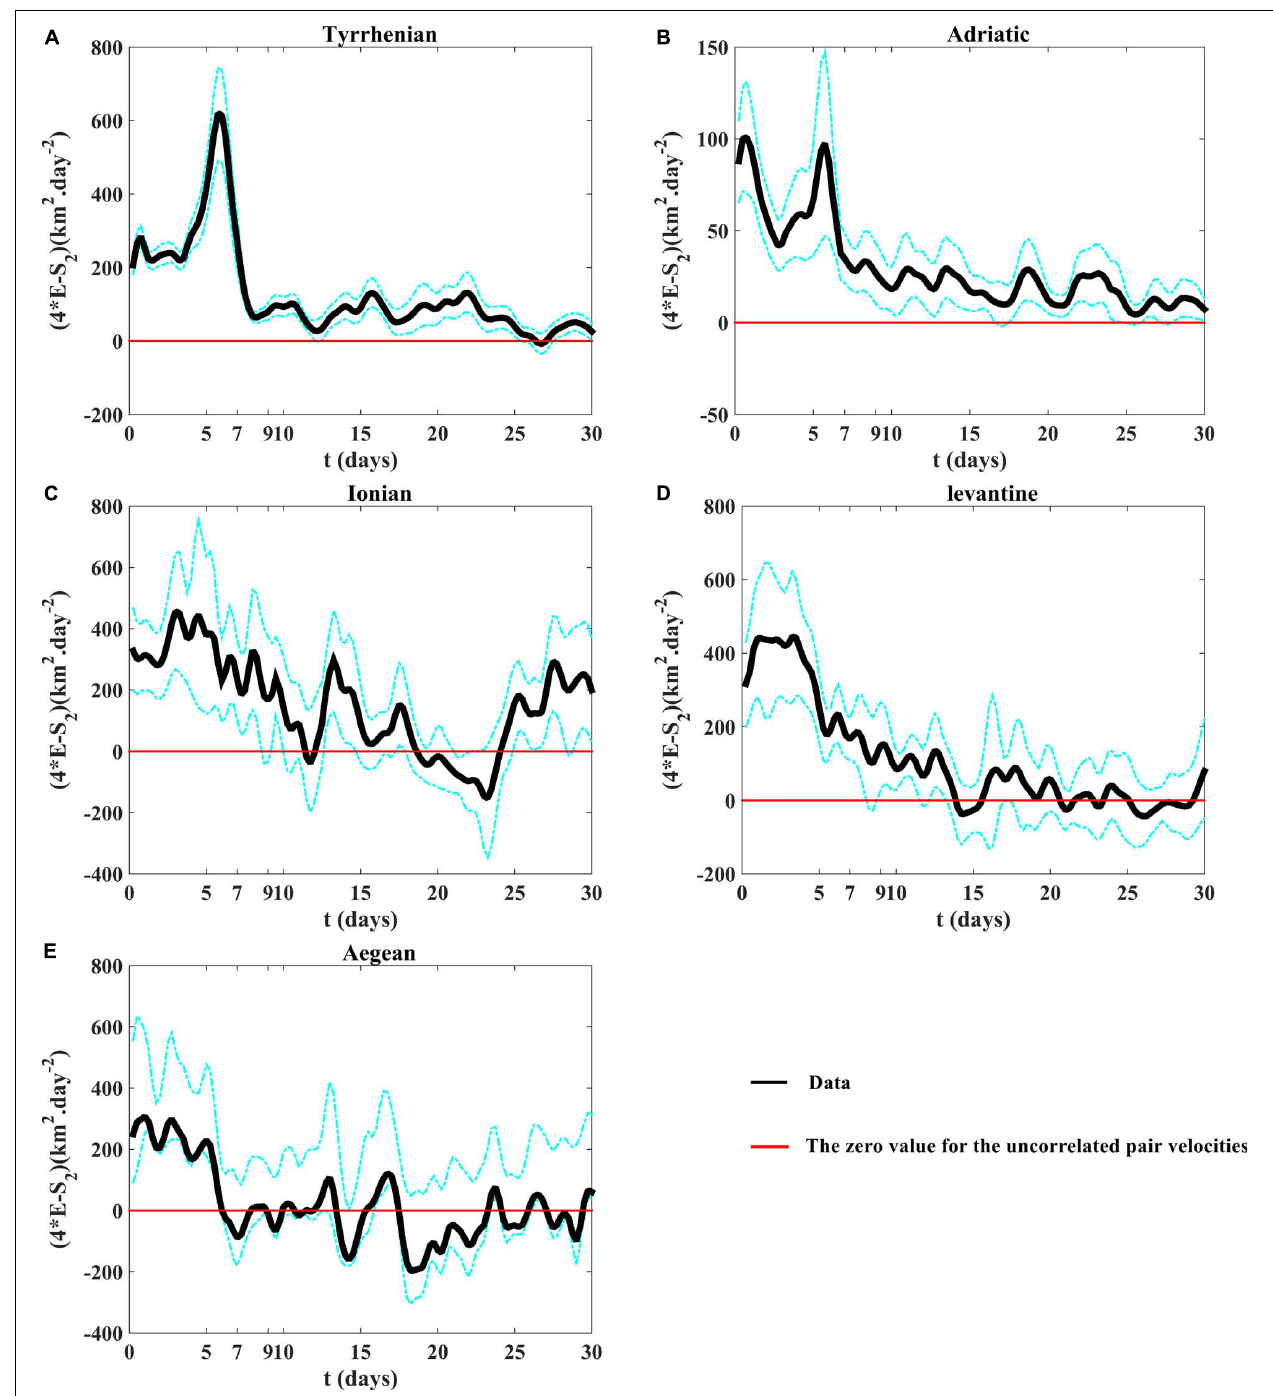
FIGURE 8 | The difference between the four time eddy kinetic energy 4E and the second-order structure function S 2 as a function of time (4E–S 2 )(t) (A) in the Tyrrhenian, (B) the Adriatic, (C) the Ionian, (D) the Levantine, and (E) the Aegean sub-basins. The uncorrelated pair velocities would have a (4E—S 2 ) of zero (horizontal red lines). The dashed cyan lines indicate the 90% confidence intervals from bootstrap resampling, give a rough idea of the uncertainties for the statistics.